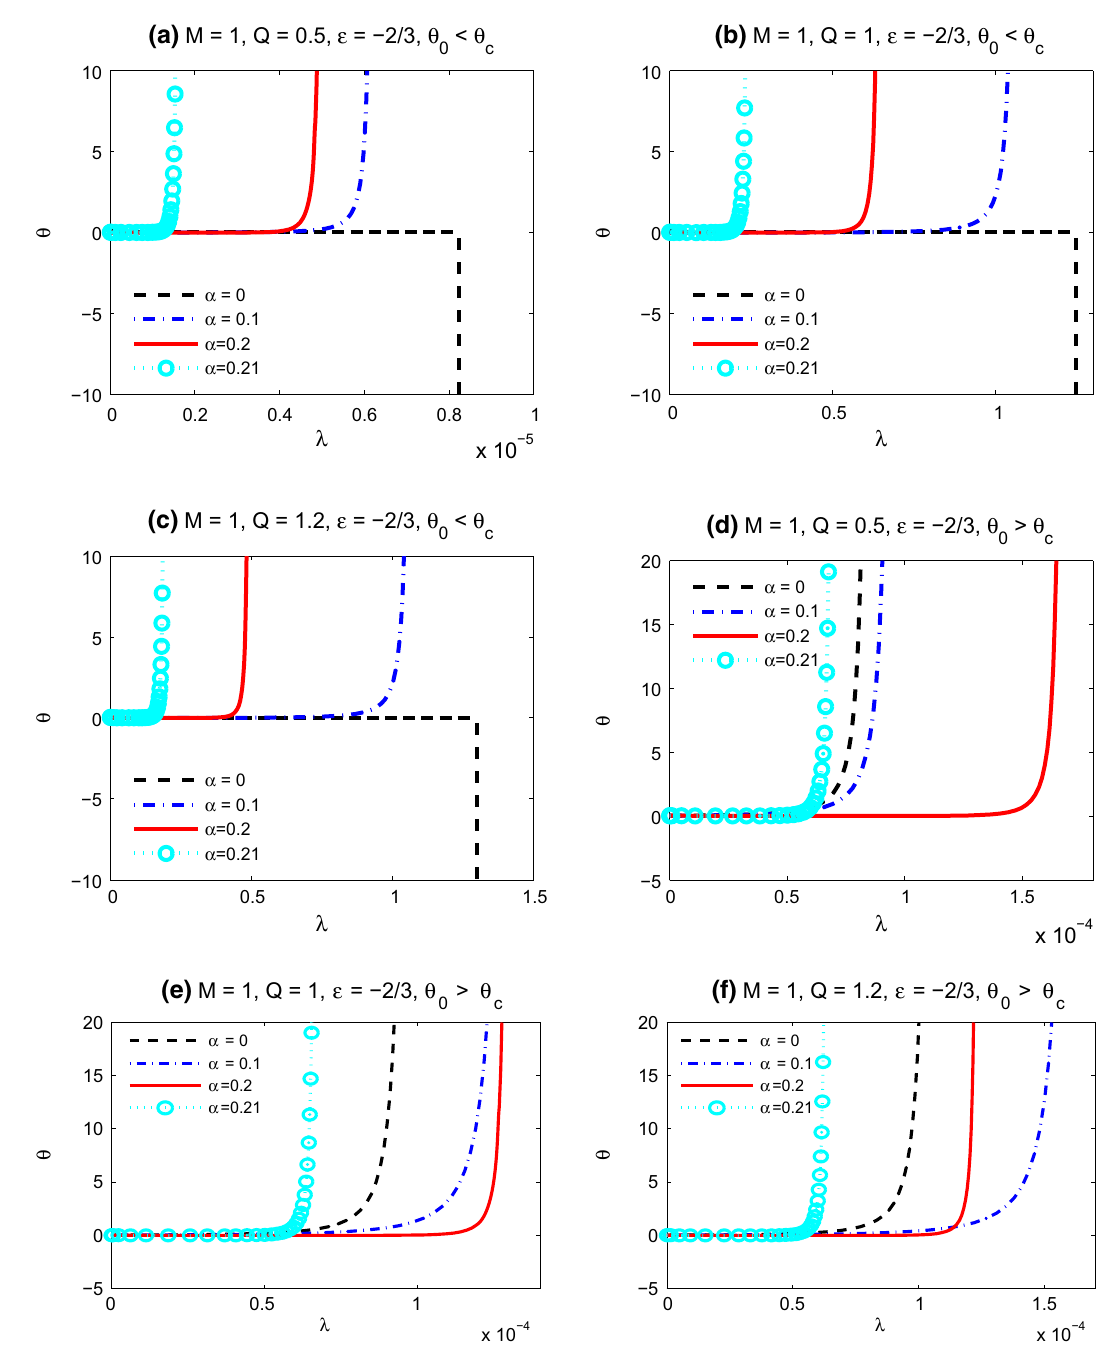
Fig. 4 The evolution of expansion scalar ( θ ) with normalisation constant ( α ) with no initial shear and rotation for different values of charge ( Q )